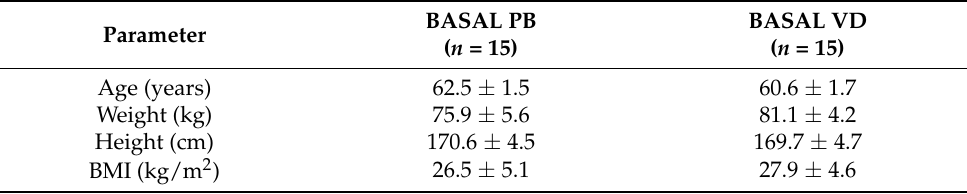
Abbreviations used: PB, placebo group; VD, vitamin D-supplemented group. Table 2. Hematological and iron metabolism parameters.